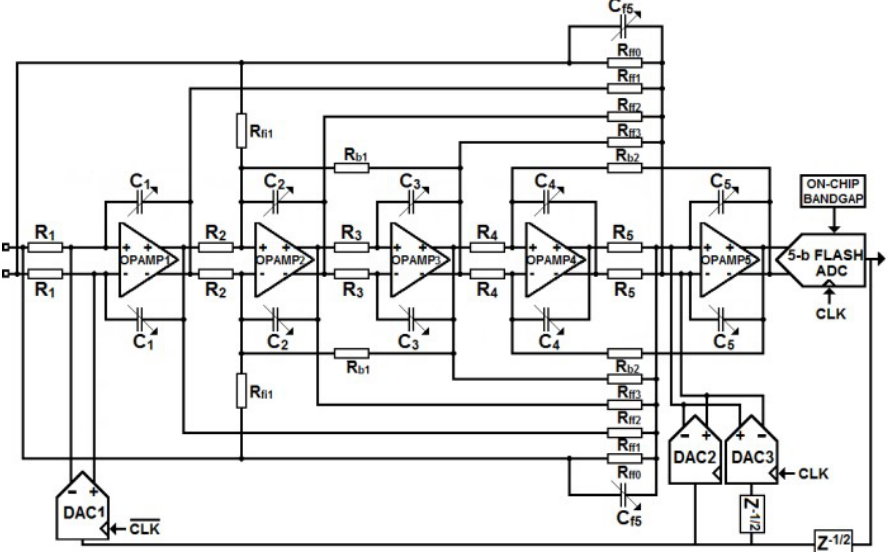
Figure 6. Circuit-level architecture of the CT ∆Σ